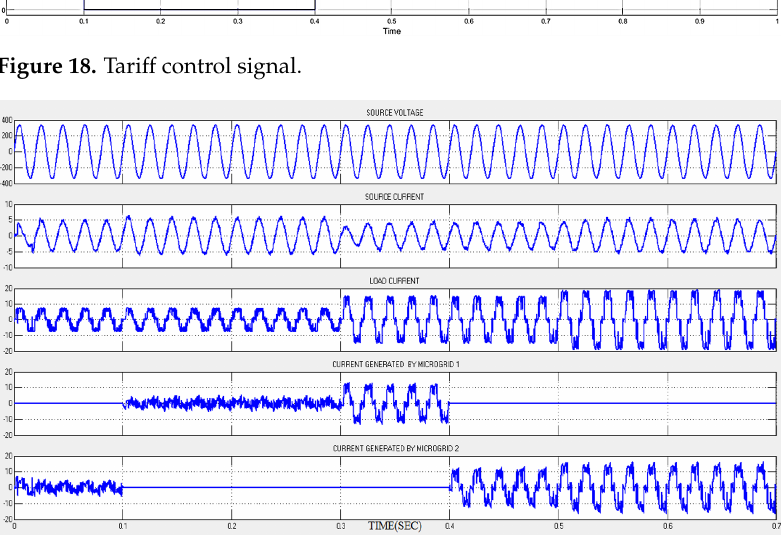
Figure 19. Voltage and current waveforms of the source, load, and each microgrid based on